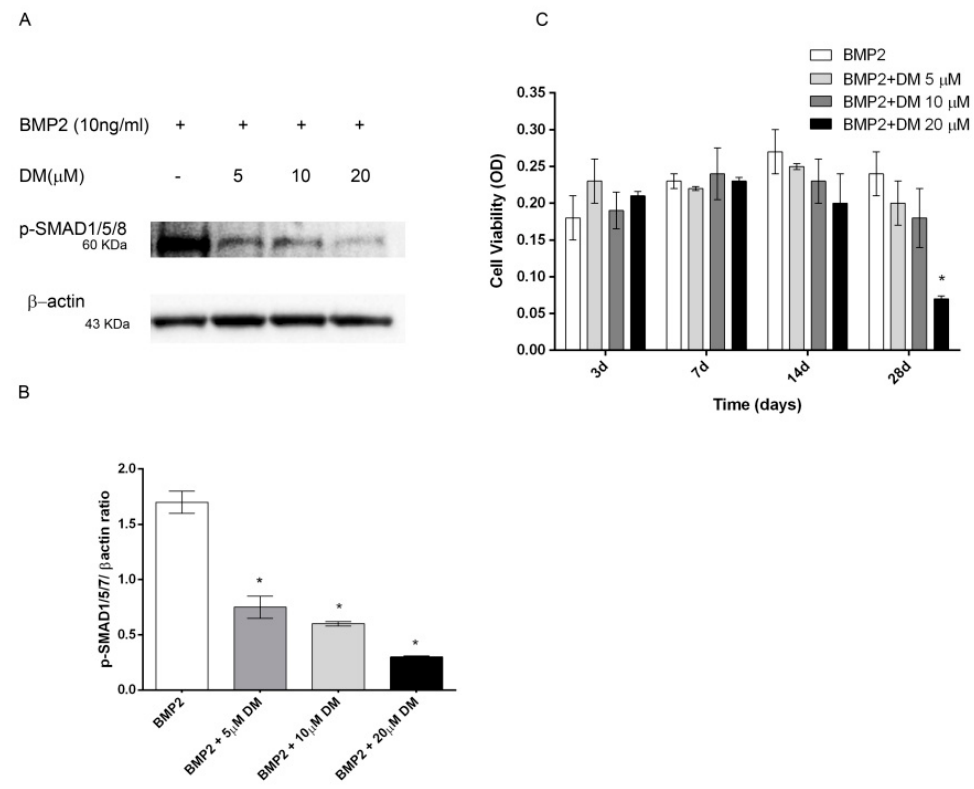
Figure 5. ( A ) Dose-response e ff ects of DM on SMAD1 / 5 / 8 activation and ( B ) hMSCs viability in the presence of BMP2 (10 ng / mL). hMSCs cultured in OM + BMP2 and treated with increasing doses of DM (0, 5, 10, 20 µ M). ( A ) Cell lysates electrophoresed and immunoblotted with phospho SMAD1 / 5 / 8 antibody. β -actin antibody used to ensure equivalent sample loading. ( B ) Graphical representation of densitometry and Western blotting quantitative data. ( C ) Cell viability evaluated at di ff erent time points (3, 7, 14, 28 days). *: p ≤ 0.05 vs. BMP2 at the corresponding time point.